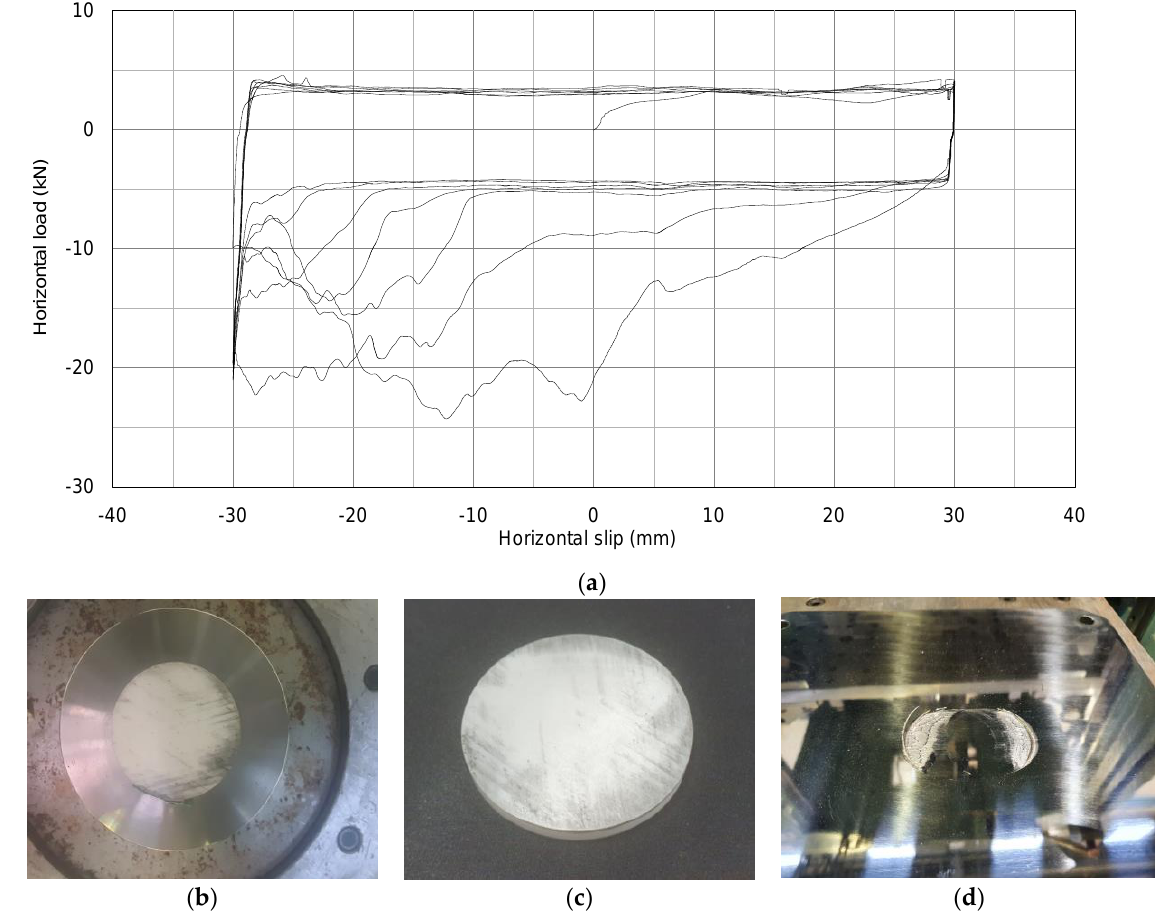
Figure 5. Friction test results: ( a ) horizontal load-slip curve; ( b ) deformation of ceramic friction material; ( c ) surface of ceramic friction material; ( d ) deformation of sliding plate.